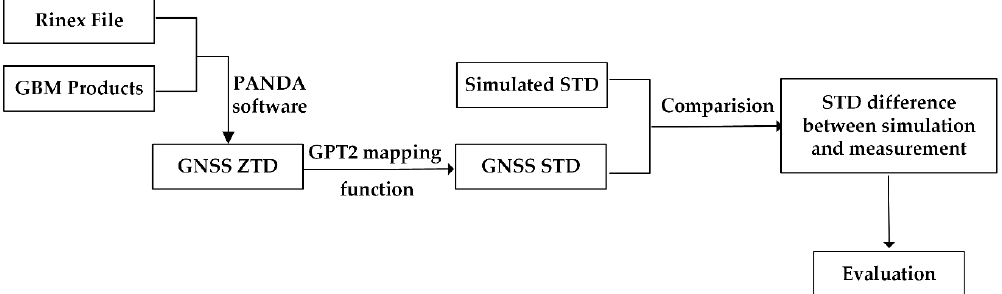
Figure 3. Flow chart of simulated STD evaluation. Figure. 3 Flow chart of simulated STD evaluation. Figure. 3 Flow chart of simulated STD evaluation.